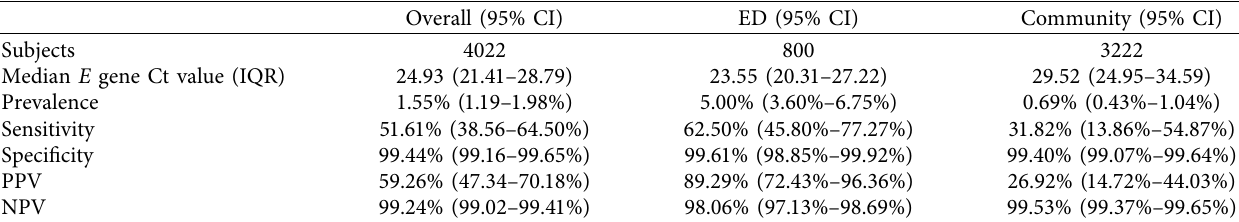
Table 1: Clinical performance of the VTRUST COVID-19 Antigen Rapid Test with respect to RT-PCR results.